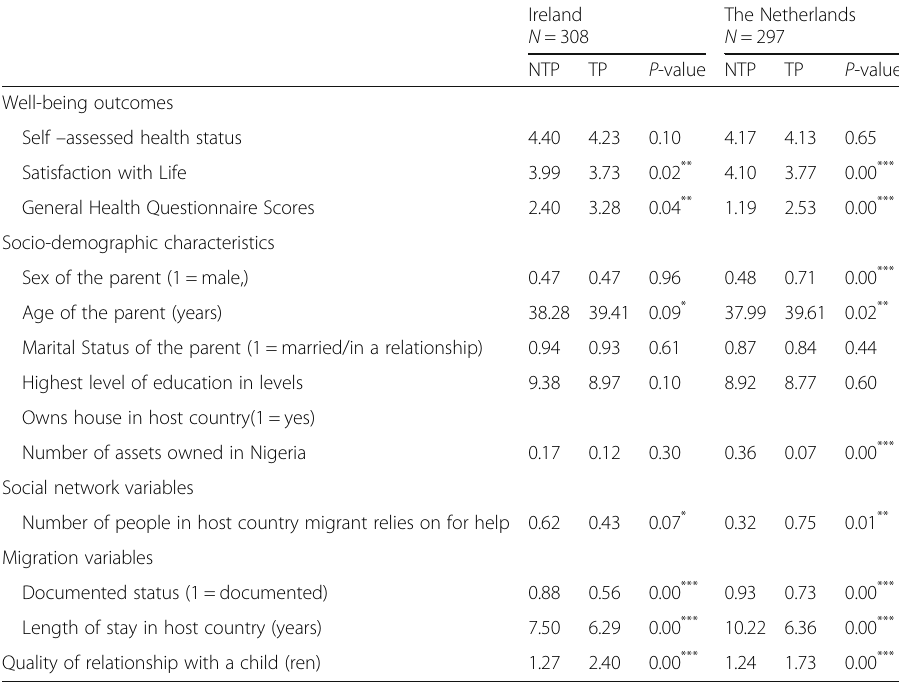
Table 2 Descriptive Statistics by Transnational Parenting